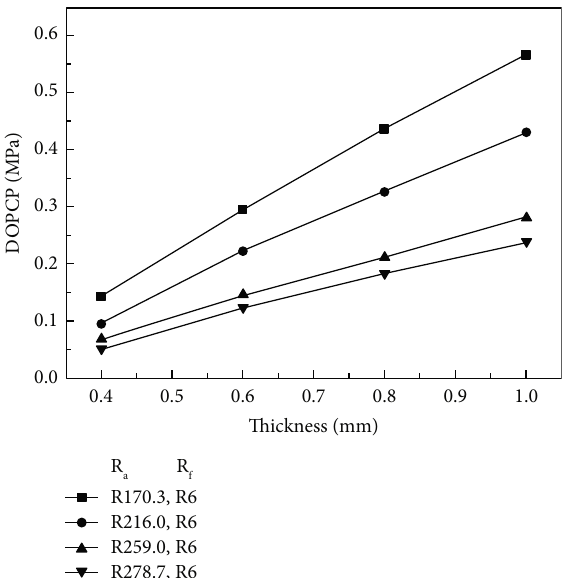
Figure 11: Variation of DOPCP and